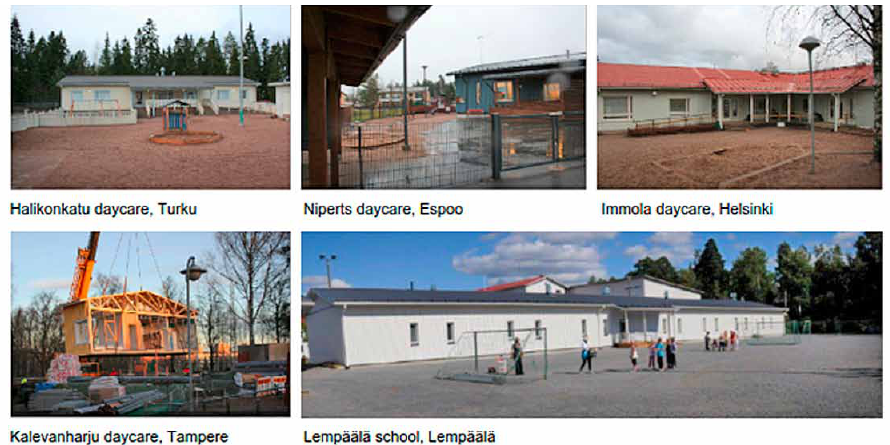
fig. 3. images of the case study